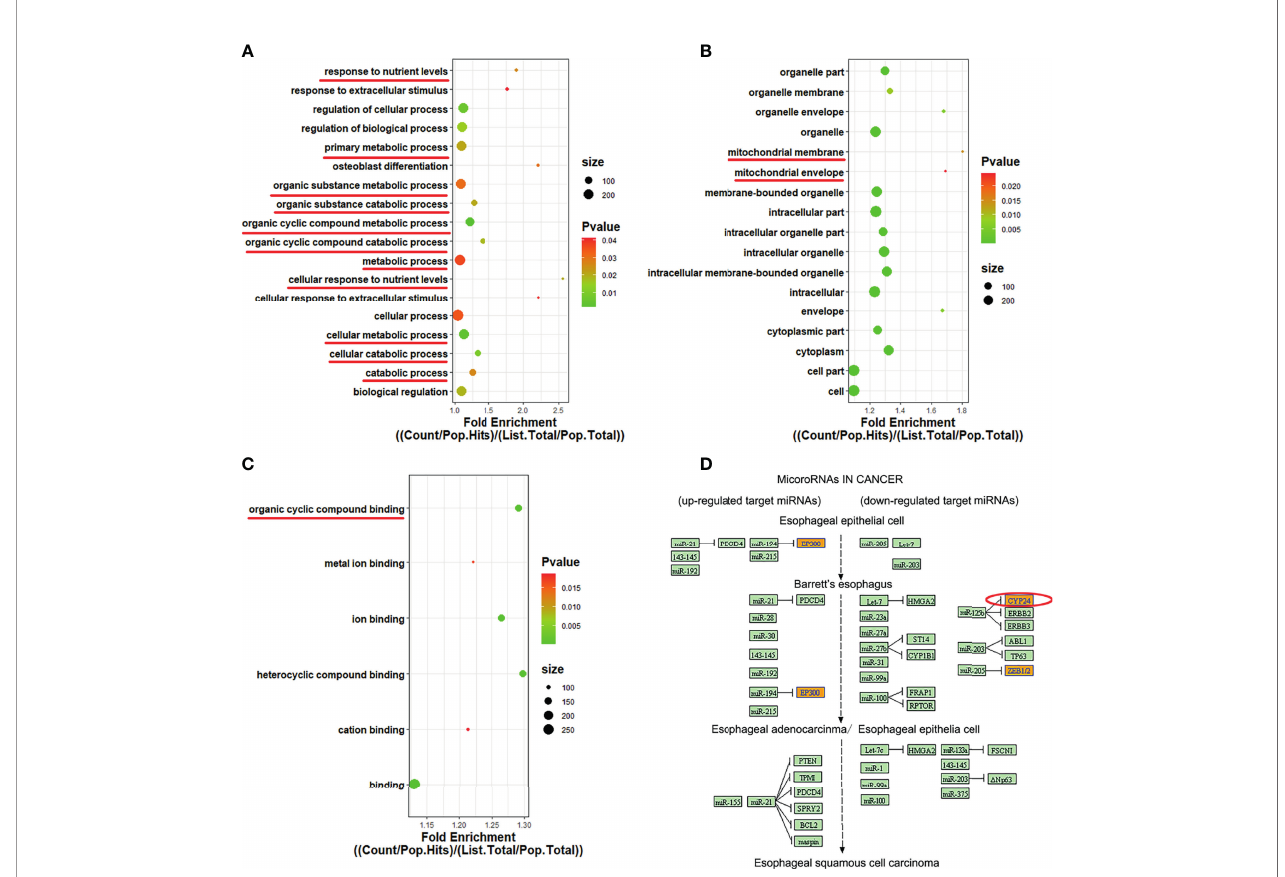
FIGURE 4 | GO enrichment and KEGG pathway analysis of has_circ_0060927. (A – C) GO terms were exhibited in BP, CC, and MF bubble diagram, respectively. (D) KEGG pathway involved in has_circ_0060927.